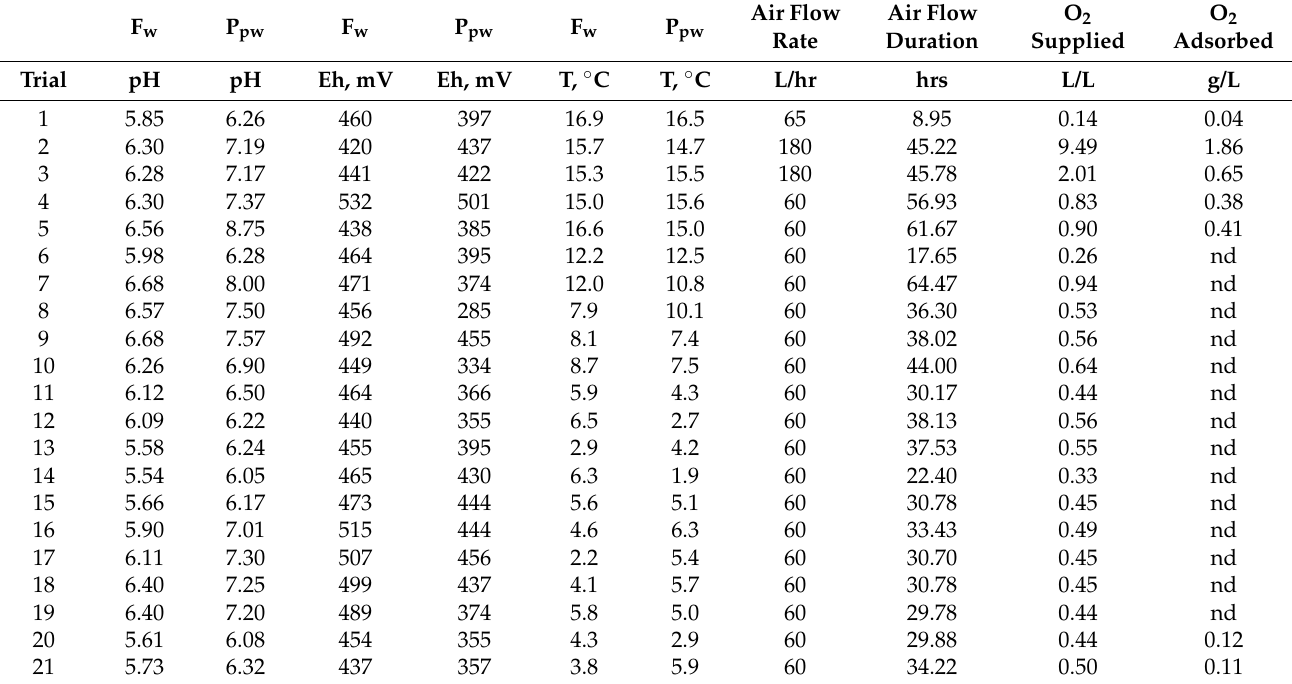
Table A1. Basic parameters associated with each trial. F w = feed water; P pw = product